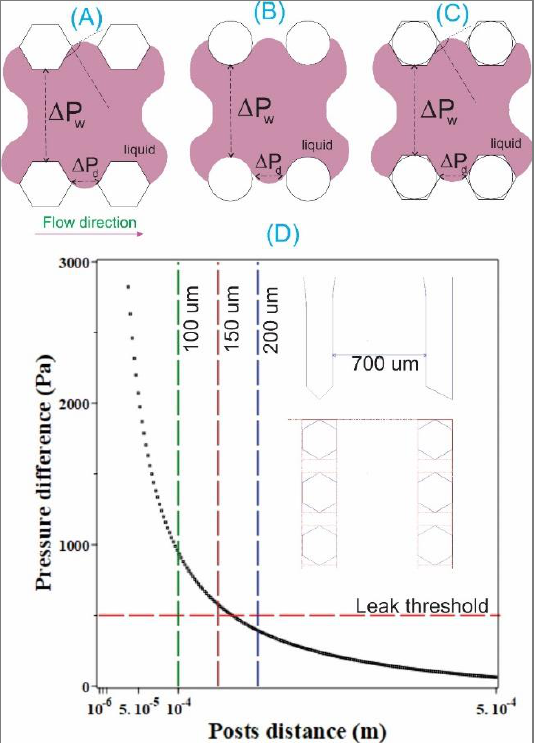
Figure 3. Schematics to illustrate the pressure differential  P d and  P w for cases of using ( A ) hexag- onal and ( B ) circular micro-posts. Figure 3A is inspired by the work of Huang, C.P., et al. [5], Figure 3 B for the circular post is our new design. ( C ) Illustration for the imposition of a circle inscribed on